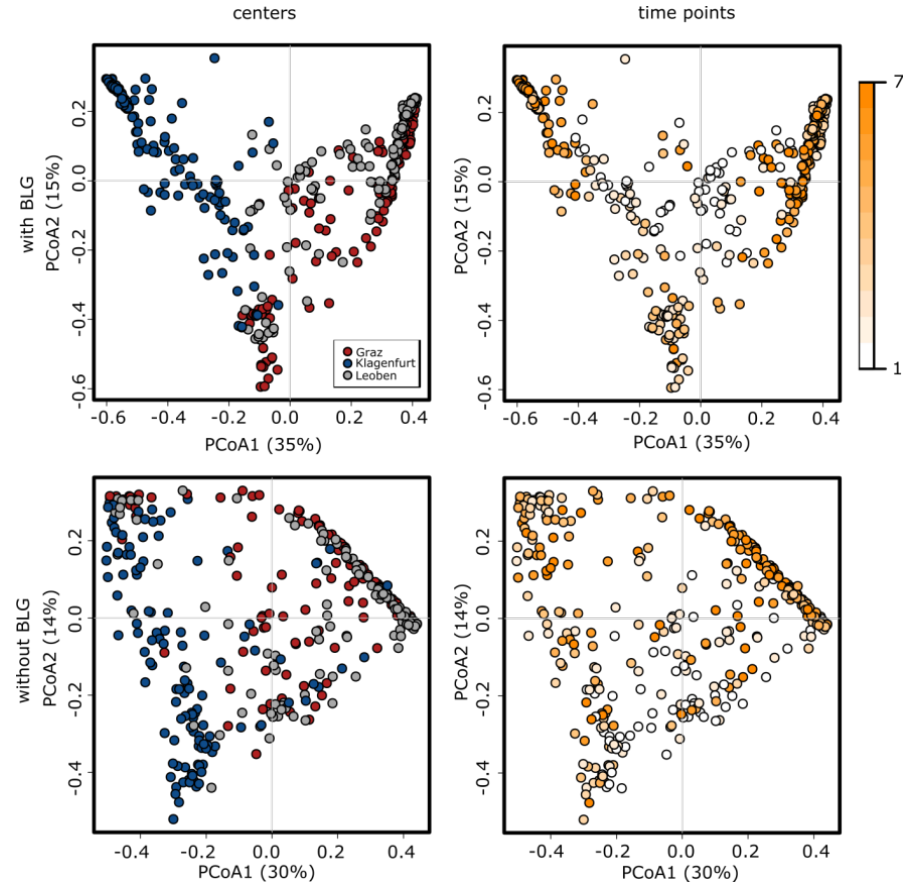
Figure 4. PCoA (Principal Coordinates Analysis) plots displaying the changes in microbial profiles in samples from the three centers over time. Analysis shown with BLG ( Bifidobacterium, Lactobacillus, Geobacillus ) included (upper panels) and without (removed from the dataset, lower panels). Centers are indicated by different colors (red: G, blue: K, grey: L; left panels). Time points of sampling are indicated by shades of orange (white: t1, dark orange: t7; right panels).